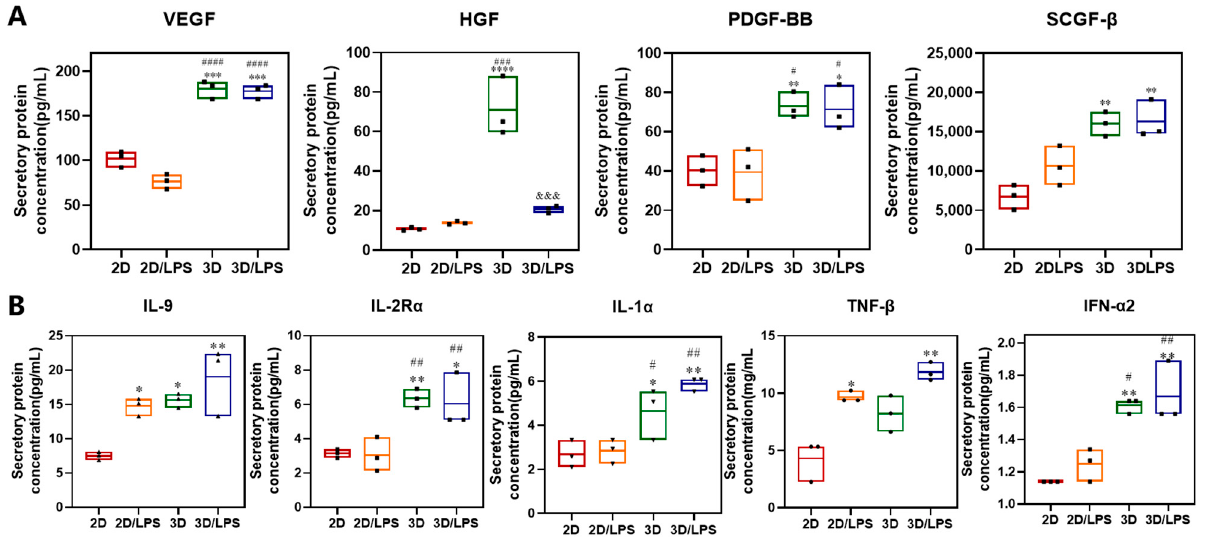
Figure 9. Immune cytokine assay of PDLSC-derived secretome after LPS and/or 3D culture treat- ment. ( A ) Growth factor expression in 2D-, 2D/LPS–, 3D and 3D/LPS-group-derived secretome. ( B ) Inflammatory cytokine expression in 2D-, 2D/LPS–, 3D and 3D/LPS-group-derived secretome. * p < 0.05, ** p < 0.01, *** p < 0.001, **** p < 0.0001, compared with 2D group; # p < 0.05, ## p < 0.01, ### p < 0.001, #### p < 0.0001, compared with 2D/LPS group; &&& p < 0.001, compared with 3D group.